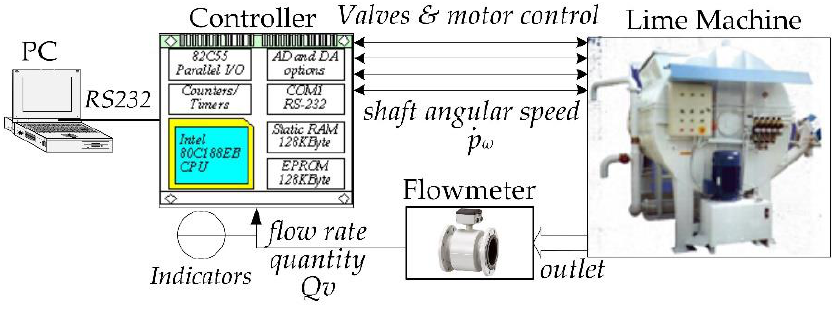
Figure 7. Lime mash / slurry machine custom-build control Figure 7. Lime mash/slurry machine custom-build control system.